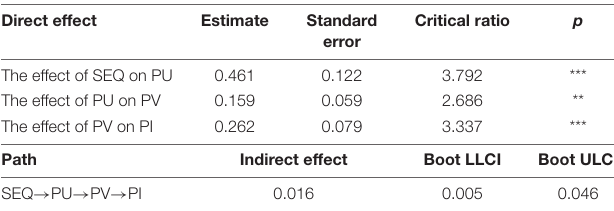
TABLE 10 | Results of path analysis